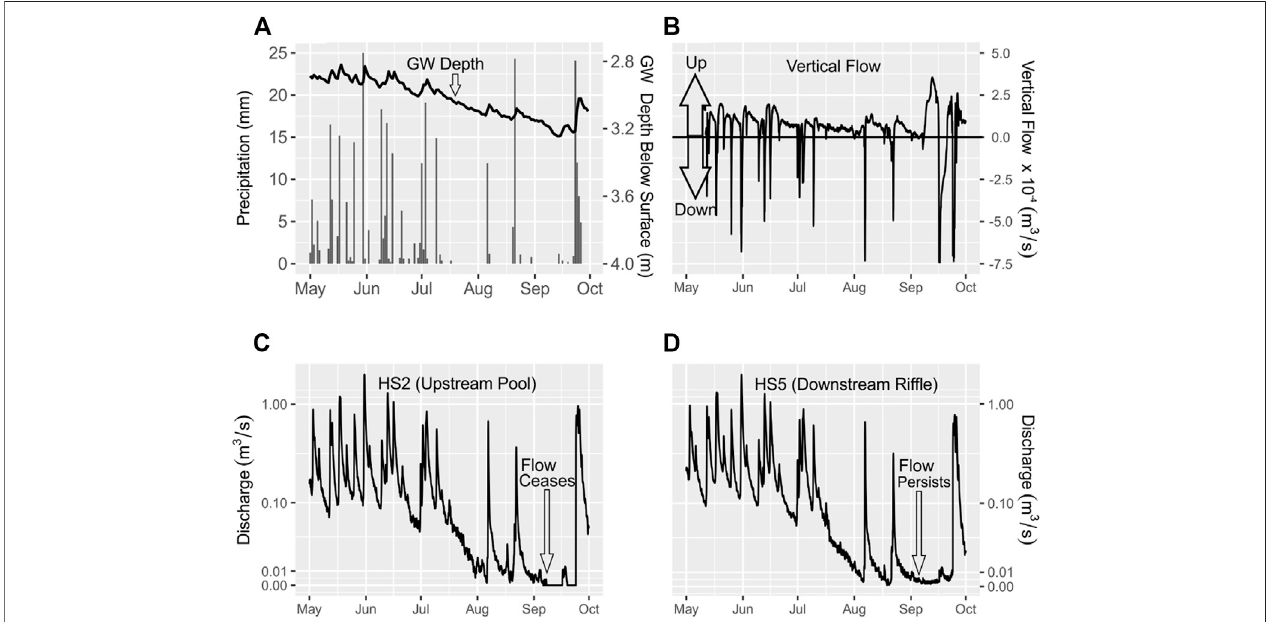
FIGURE 4 | (A) Mean daily depth to groundwater level below the ground surface in MW02 and total daily precipitation recorded at the Abbotsford International AirportStation. (B) Vertical fl owacrossthestreambedbetweentransectR5andtransectP3.Positivevaluesabovetheblackhorizontallineindicateupward fl ow(gaining stream), and negative values below the red line indicate downward fl ow (losing stream). (C) Discharge at HS2, which is located in a pool in the upstream segment of the Otter Park reach (D) Discharge at HS5, which is located in a rif fl e in the downstream segment of the Otter Park reach. Discharge is plotted on a pseudo-log scale, which plots values closer to zero on a linear scale. Refer to Figure 3 for locations of